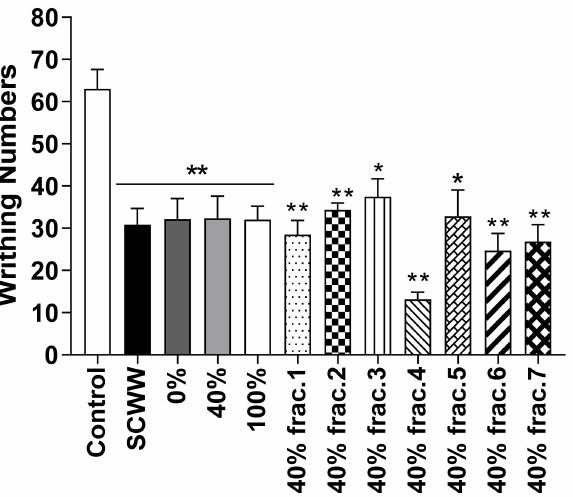
Figure 8. Effect of isolated sub-fractions from water layer of Symplocos chinensis f. pilosa Ohwi water extract in the acetic acid-induced abdominal writhing test. Data are expressed as mean ± SD; n = 6 mice per group. (* p < 0.01, ** p < 0.001 vs. control group).